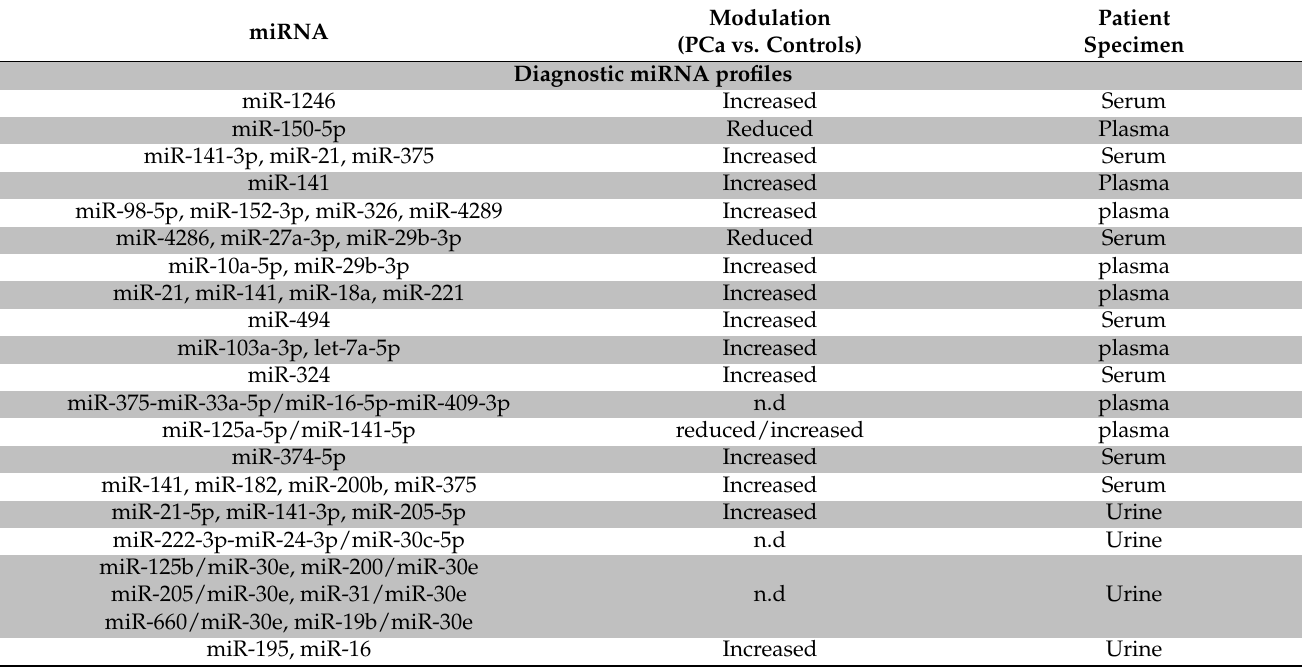
Table 2. miRNA profiles endowed with diagnostic and prognostic potential in prostate cancer a .